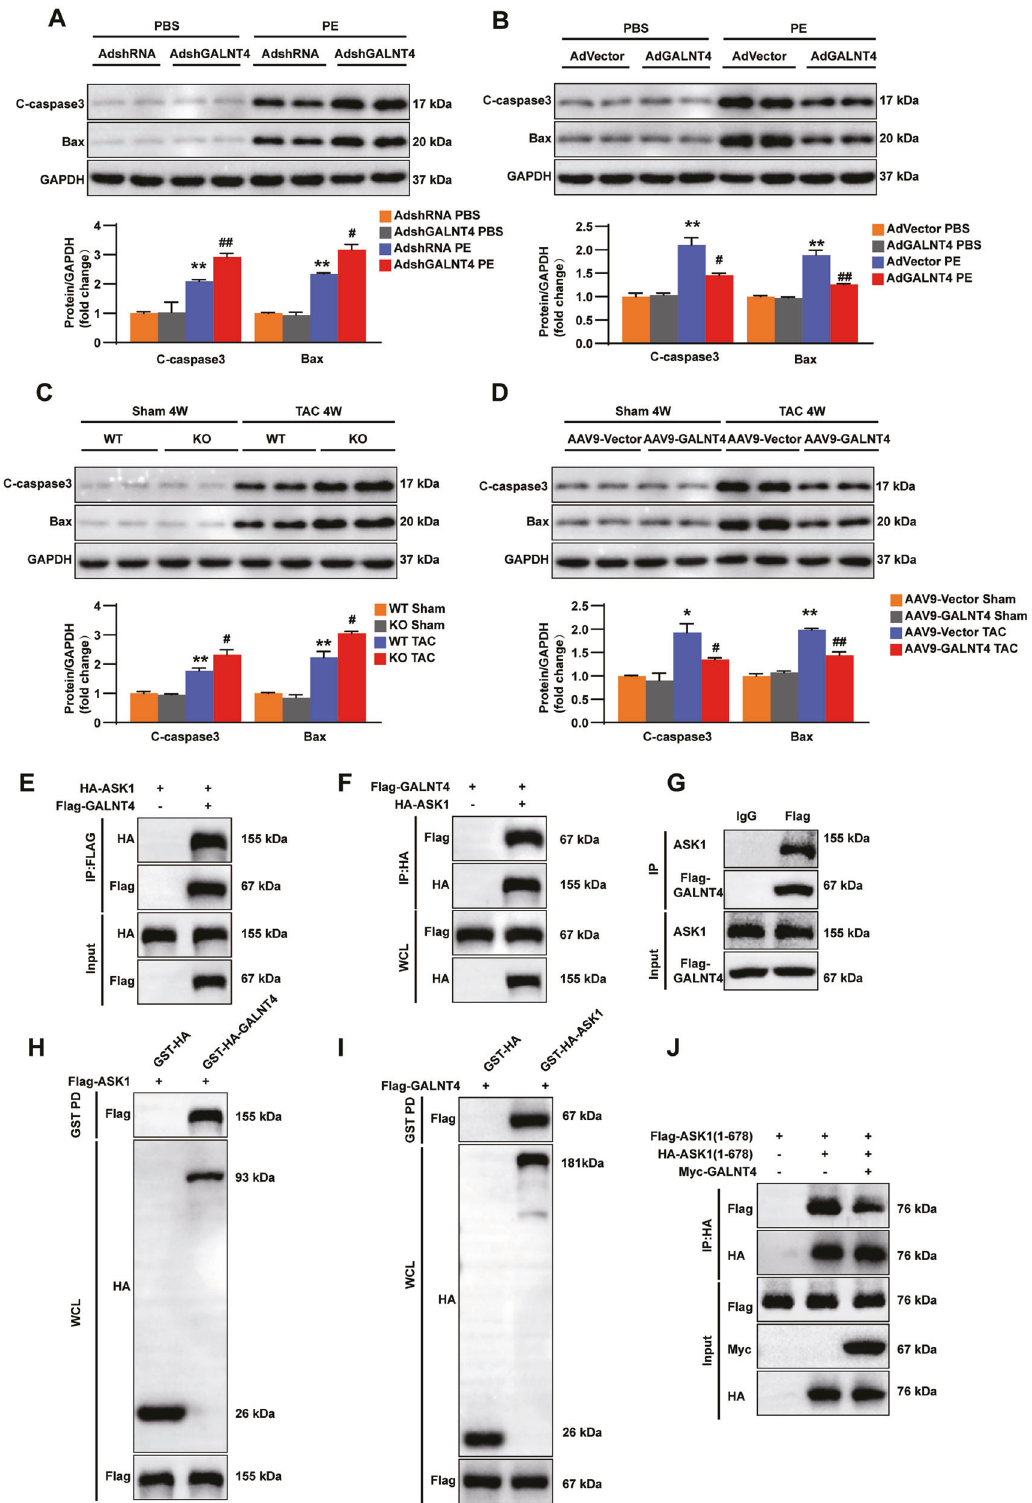
Fig. 6 GALNT4 can regulate apoptosis and directly binds to ASK1 to inhibit its oligomerization. A Knockdown of GALNT4 increases the expression of apoptotic proteins in vivo. B The overexpression of GALNT4 inhibits cardiomyocytes apoptosis. A , B ** p < 0.01 vs. AdshRNA PBS or AdVector PBS, # p < 0.05 vs. AdshRNA PE or AdVector PE, ## p < 0.01 vs. AdshRNA PE or AdVector PE. C , D The expression of Bax and C-caspase 3 in vitro. For C-D, * p < 0.05 vs. WT sham or AAV9-Vector sham, ** p < 0.01 vs. WT sham or AAV9-Vector sham, # p < 0.05 vs. WT TAC or AAV9- Vector TAC, ## p < 0.01 vs. WT TAC or AAV9-Vector TAC. E , F The interaction between GALNT4 and ASK1 in 293T cells. G The interaction between GALNT4 and ASK1 in NRCMs. H , I A GST pull down assay was used to verify the direct combination between GALNT4 and ASK1. J The effect of GALNT4 on the dimerization of ASK1 (1 – 678) in 293T cells.